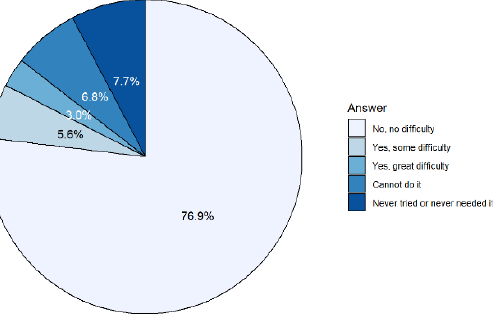
Figure 2. Difficulty in preparing meals (%) in the elderly population. Source: compiled by the authors based on data from EHSS, 2020. Table 1. Difficulty in preparing meals, by sex and age group (% by rows).